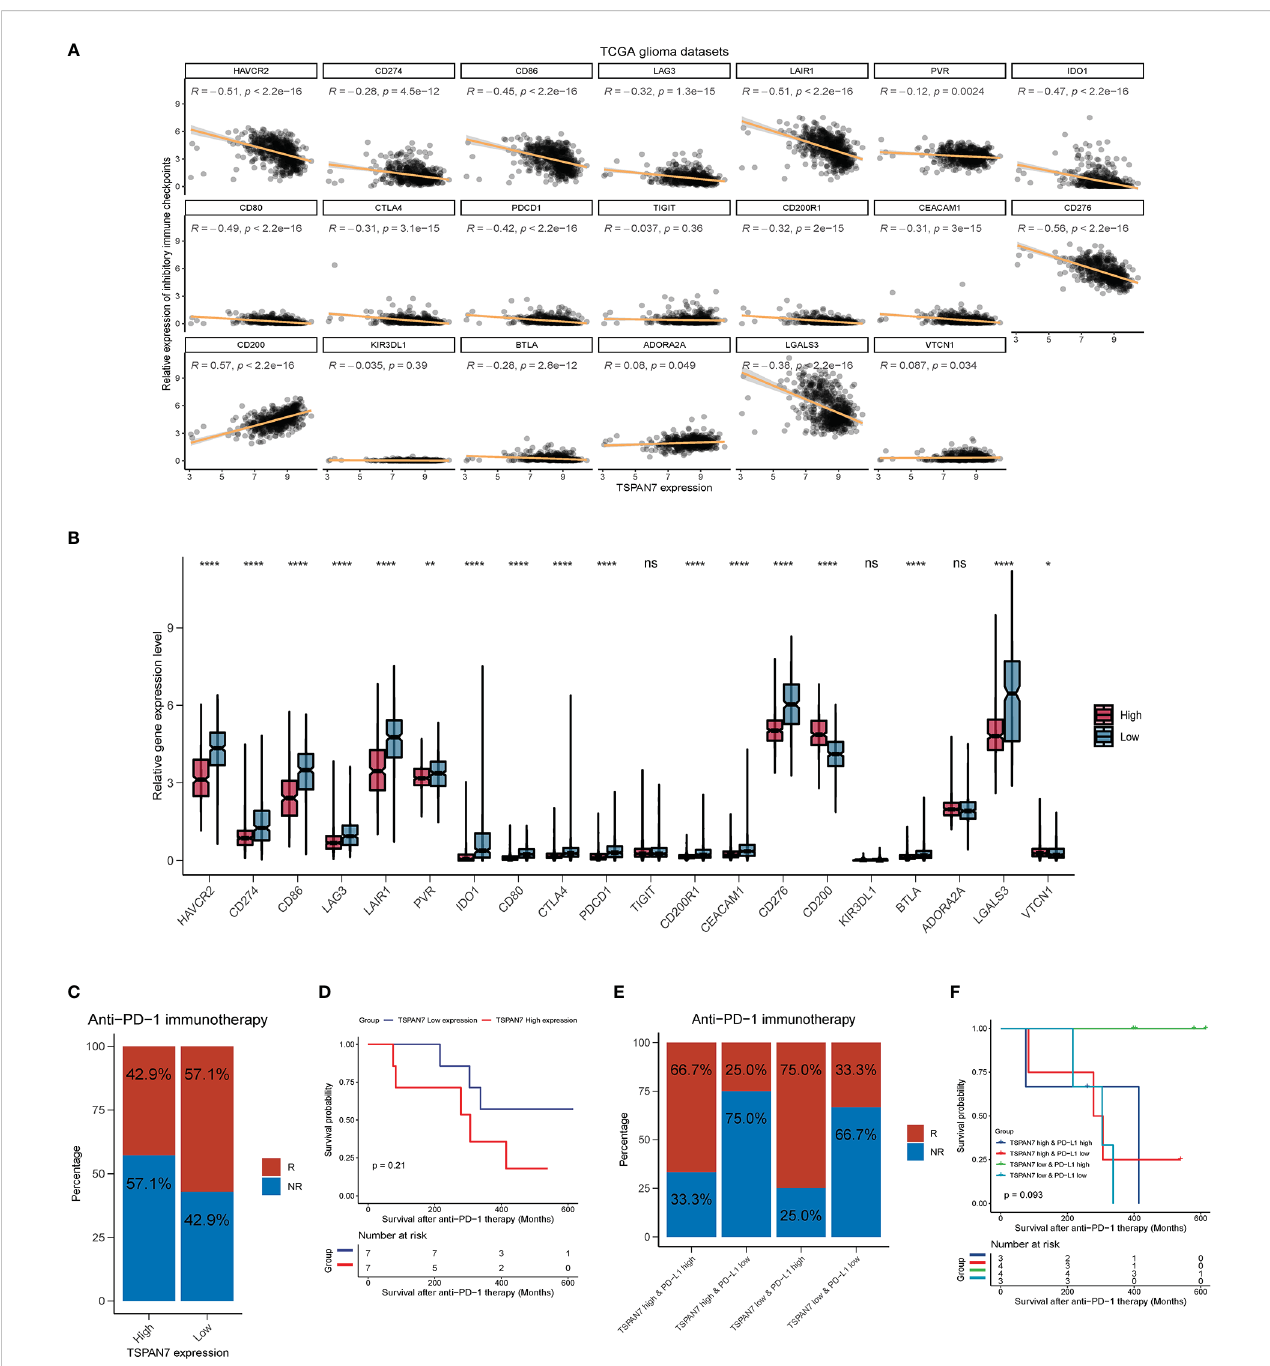
FIGURE 7 Low TSPAN7 patients are more practical to anti-PD-1 immunotherapy. (A) Correlation analysis of TSPAN7 expression with immune checkpoint markers in TCGA dataset. (B) Relative expression level differences of different immune checkpoints between TSPAN7 high expression and low expression subgroup in TCGA dataset. (C, D) Differences in the proportion of patient treatment response to anti-PD-1 immunotherapy and survival differences between TSPAN7 high and low expression subgroups. (E, F) Differences in the proportion of patient treatment response to anti-PD-1 immunotherapy and survival differences between TSPAN7 high or low expression subgroups combined with PDL1 high or low expression. *p <.05, **p <.01, ****p <.0001, ns, no